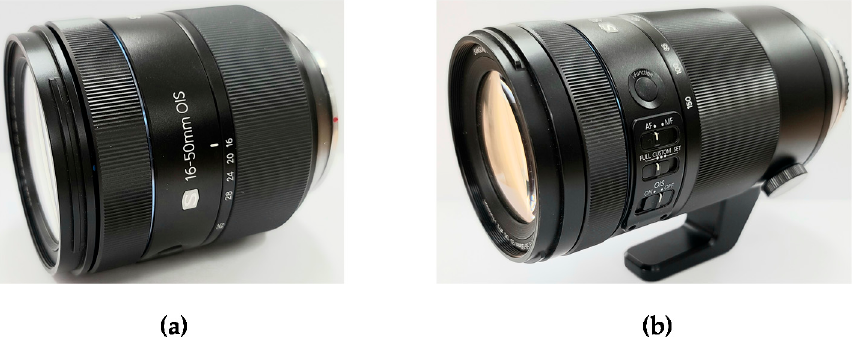
Figure 2. ( a ) Samsung NX 16-50 mm F2.0-2.8 S ED OIS [16]; ( b ) Samsung 50–150 mm F2.8 S ED OIS